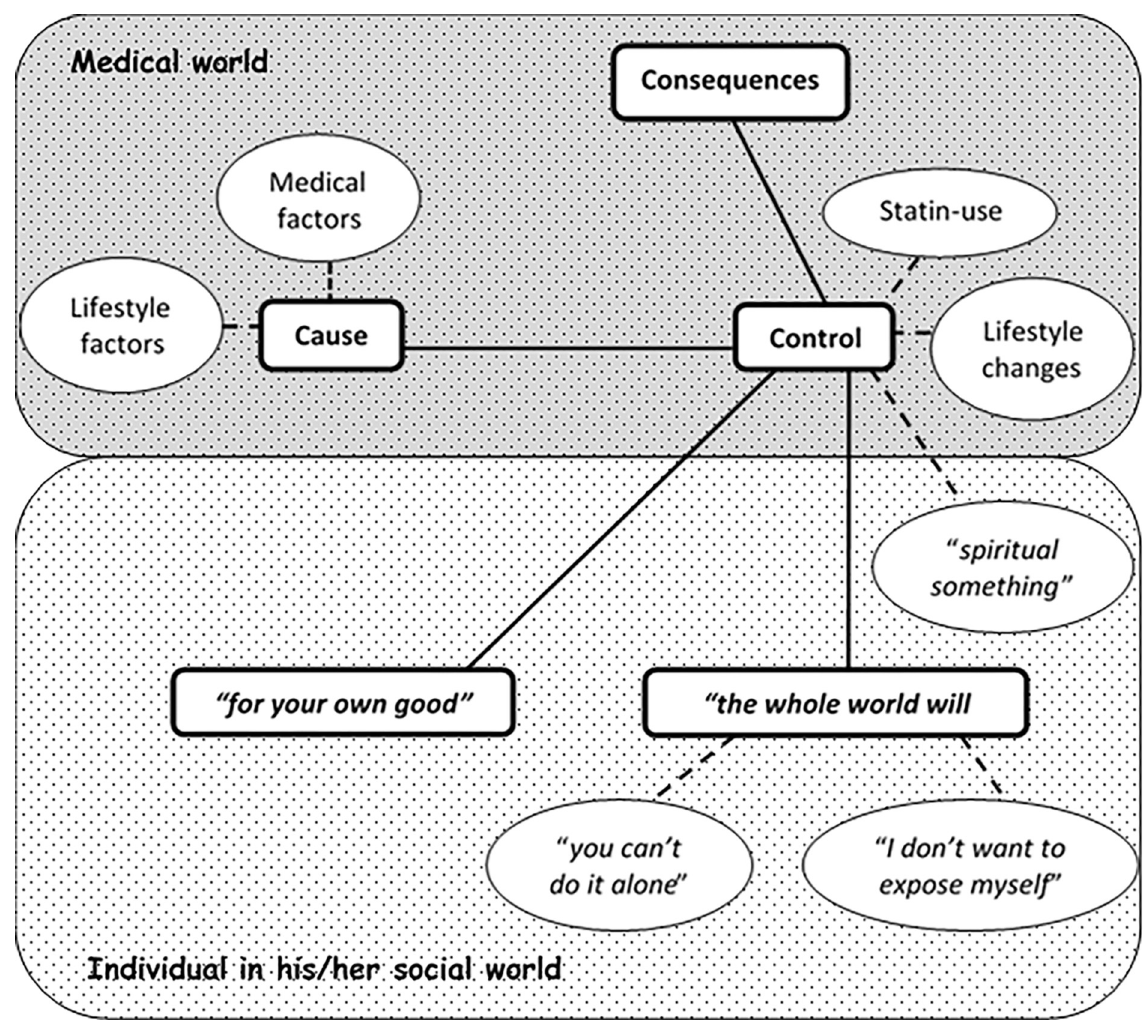
Fig 1. Thematic map.